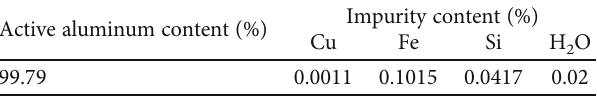
Table 1: Chemical composition of aluminum